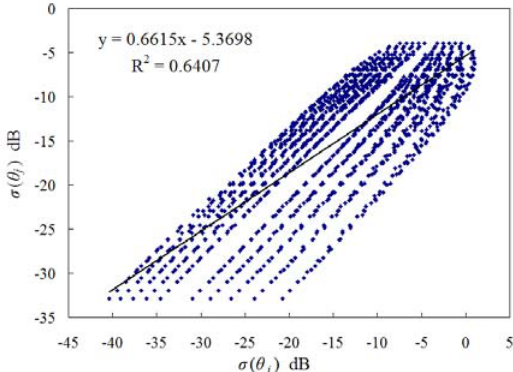
Figure. 1 Linear simulation between σ ( θ j ) and σ ( θ i ) , θ i Є [15°, 45°]), step